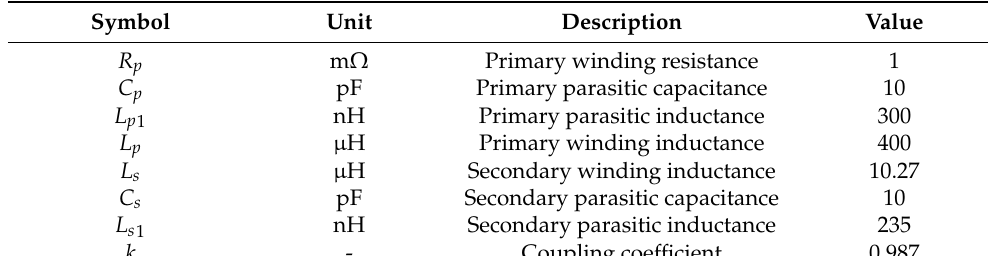
Figure 9. Flyback Transformer equivalent circuit used in SPICE Simulation.